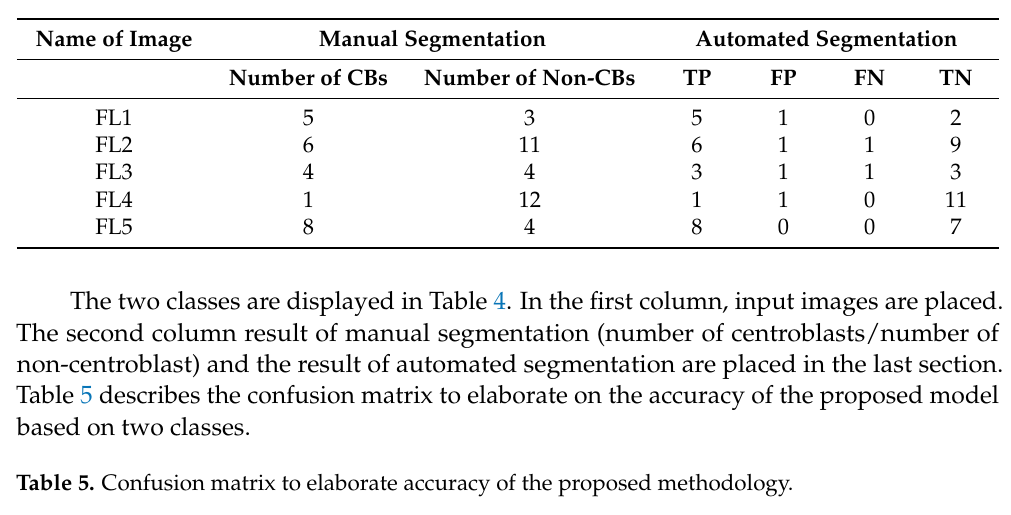
Table 4. Analysis of CB detection based on the proposed detection algorithm.